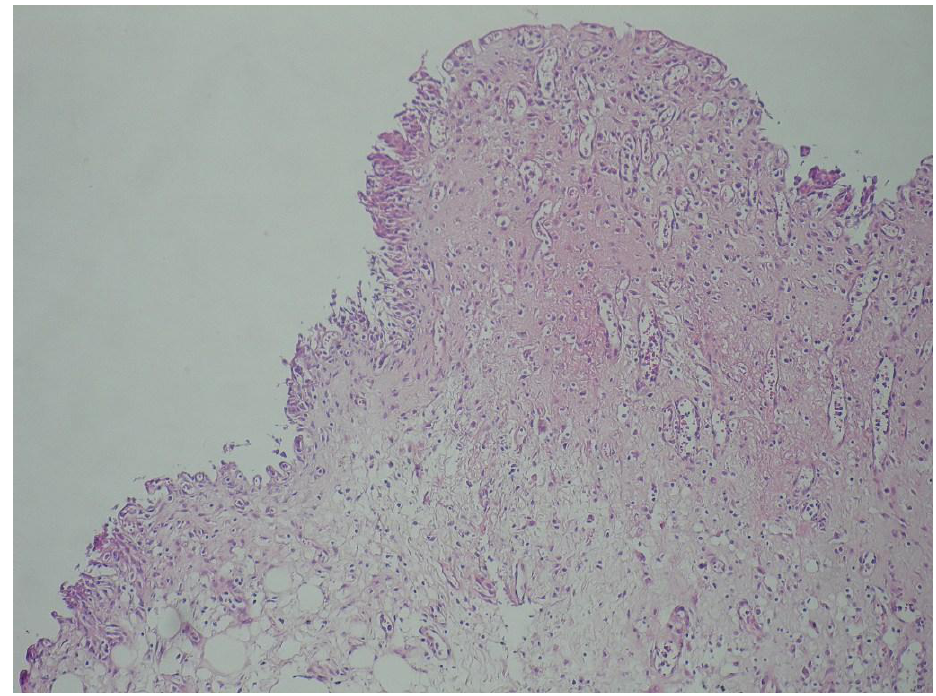
FIGURE 2 . Edema, fibrosis, few plasma cells, eosinophil leukocytes, and histiocytes were seen in the superficial lamina propria (H&E, 